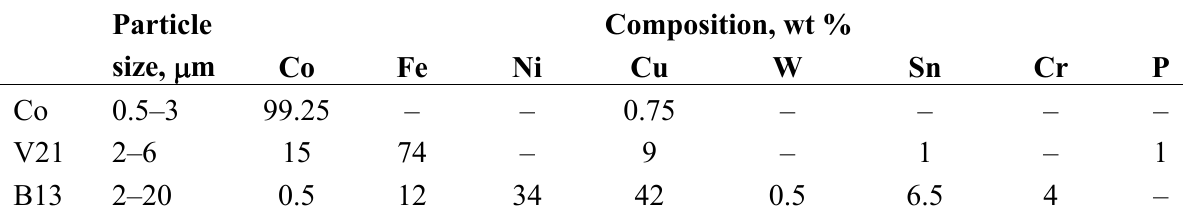
Table 4. Properties of starting powders.